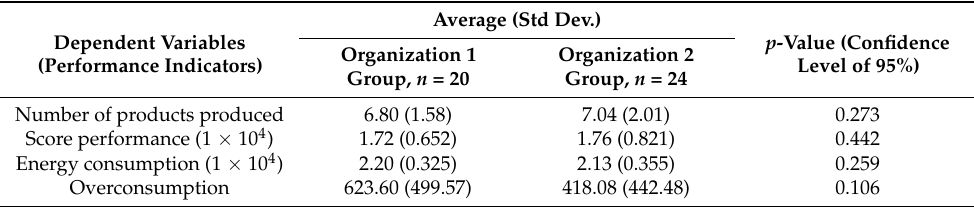
Table 1. Average of the participants’ performance per group and the result of the significance test. The energy consumption and overconsumption are in